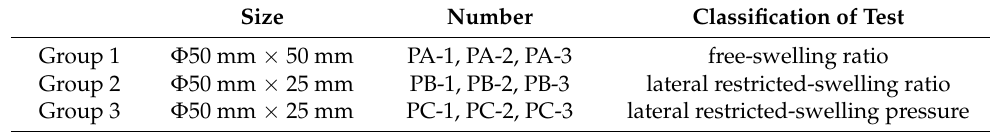
Figure 3. Gypsum rock and laboratory rock samples. Table 1. Dimensions of gypsum rock samples. Size